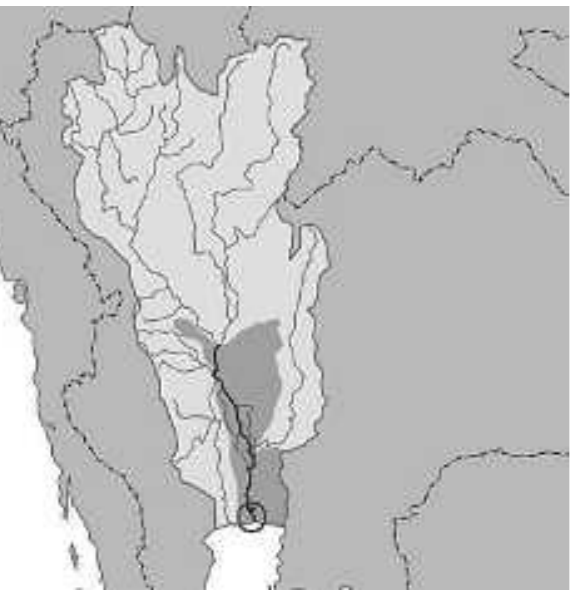
Fig 1. – Map demonstrating the settings for samples collection in this study. The area in the circle is the mouth of Chao Praya River, Thailand. The study settings are along the banks in two provinces, Bangkok and Samut Prakan